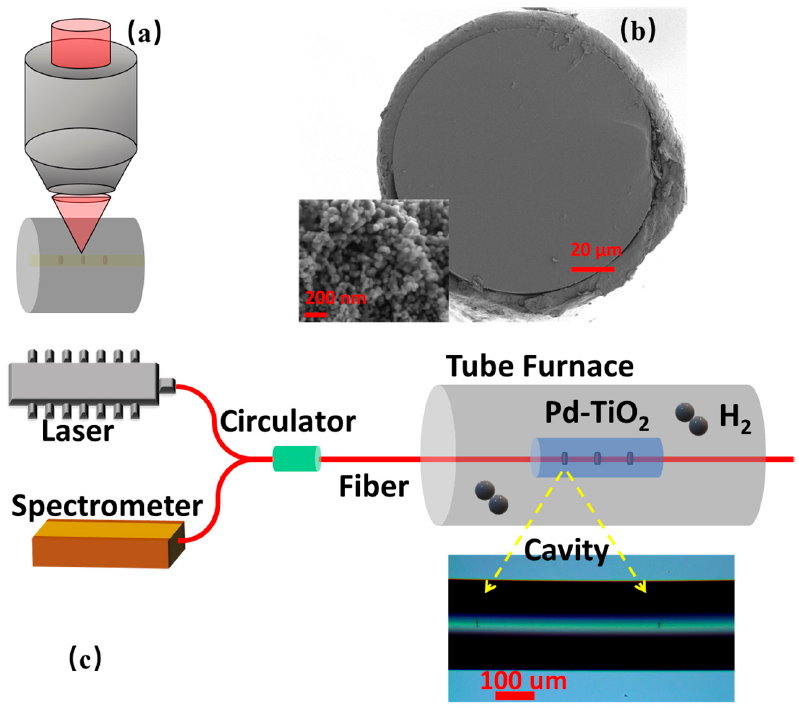
Figure 1. ( a ) Schematic of sensing cavity fabrication through laser processing. ( b ) Cross-sectional view of the fabricated sensor; inset shows the enlarged view of the sensory film. ( c ) Schematic of the experimental setup; inset shows the optical scope image of the sensing cavity after la-